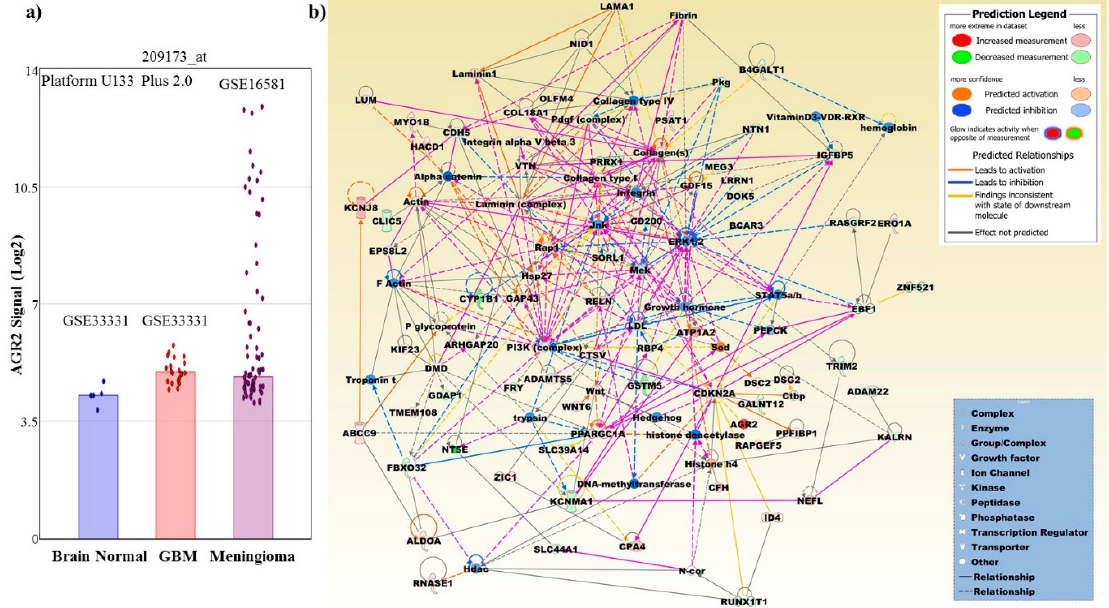
Figure 5. ( a ) Using HG 133 Plus 2.0 microarrays and a probe set (209173_at) interrogating mostly the coding region between exon 4 to exon 8, a significant higher expression is revealed for meningiomas compared to normal brain tissue and GBM. Normal brain and GBM files were derived from GEO submission GSE33331 and meningiomas from GSE16581. Dots indicate expression values of individual samples. Files were analyzed using Transcriptome Analysis Software (Thermo Fisher Scientific). Stars mark p -values < 0.05. ( b ) The merged network is based on the top three networks that